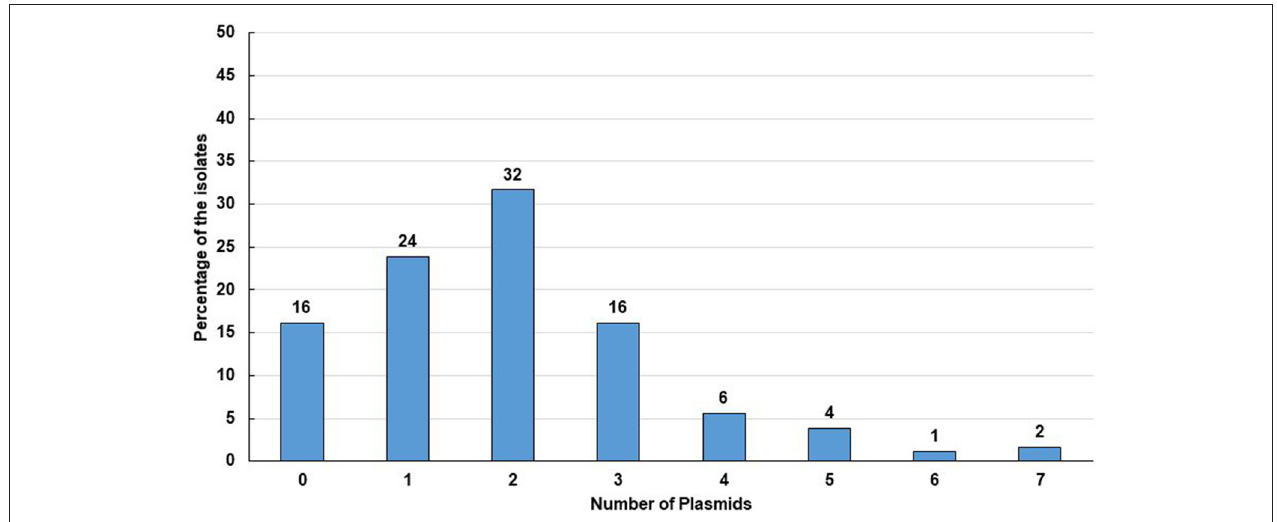
FIGURE 4 | Percentage of isolates with number of plasmids they contained. Tweenty nine isolates contained no plasmid which comprises 16% of the total isolates. Accordingly, 43 (24%) of the isolates contained a single plasmid, 57 (32%) isolates contained double plasmids, 29 (16%) isolates contained 3 plasmids, 10 (6%)